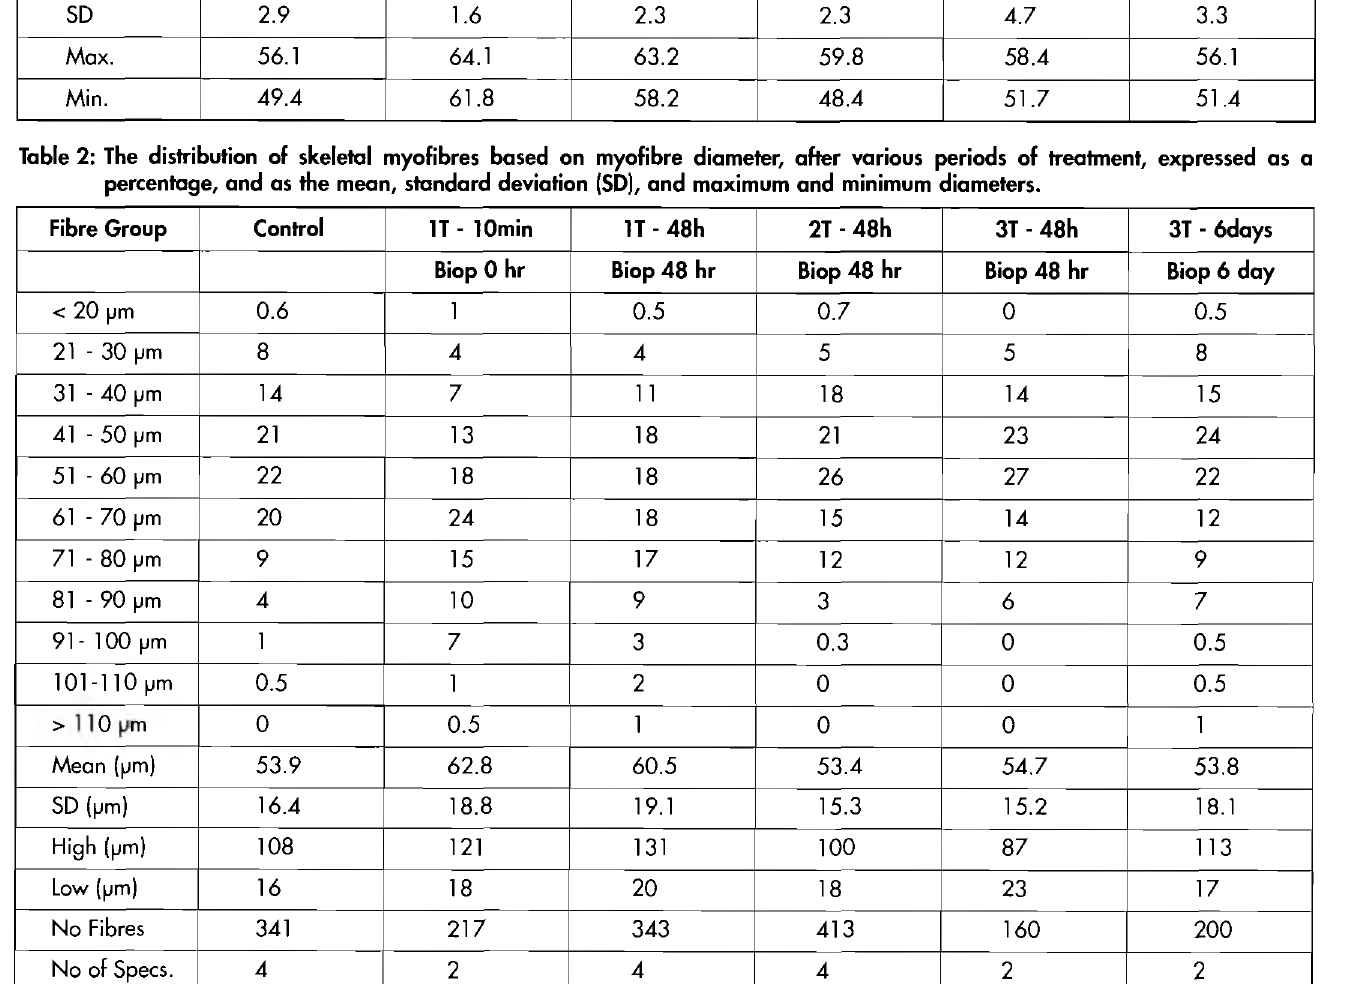
Table 2: The distribution of skeletal myofibres based on myofibre diameter, after various periods of treatment, expressed as a percentage, and as the mean, standard deviation (SD), and maximum and minimum diameters. Fibre